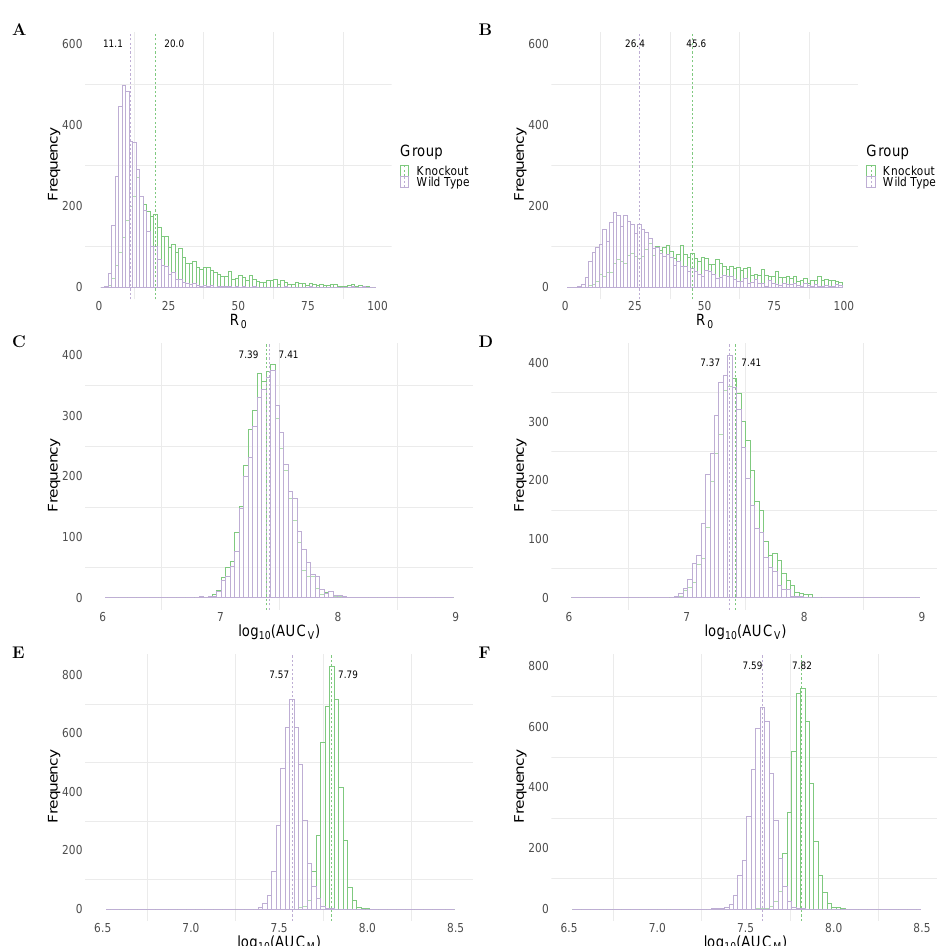
1 Figure 2. Comparison of model predictions for selected key biological quantities. Distributions are calculated using the 4000 joint posterior distributions. Panels ( A , B ) show the distribution of the basic reproduction number of viral replication in wildtype (purple) and MUC1-knockout (green) group in TIV ( left panel) and IR models ( right panel), respectively. Panels ( C , D ) show the distribution of the cumulative viral load in different mice groups in the two models. Panels ( E , F ) show the accumulative macrophages in WT and MUC1-KO mice group in the two